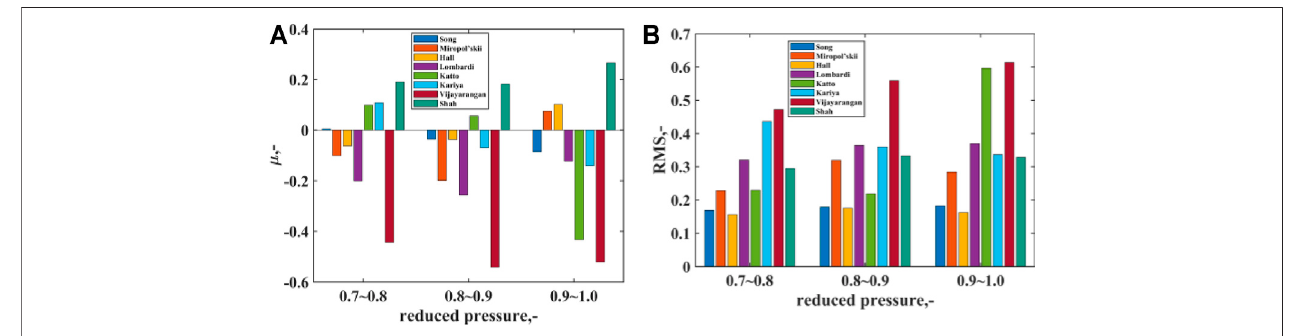
FIGURE 5 | Mean error and RMS error in different reduced pressure ranges. (A) Mean error. (B) RMS.